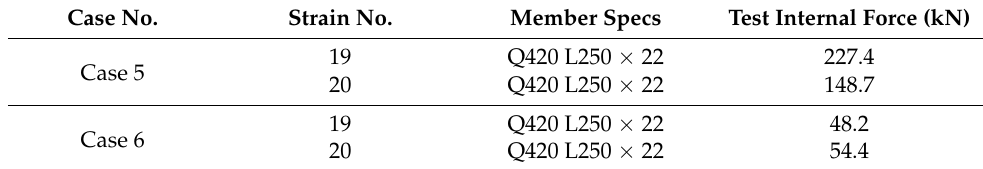
Table 4. The test results of members.